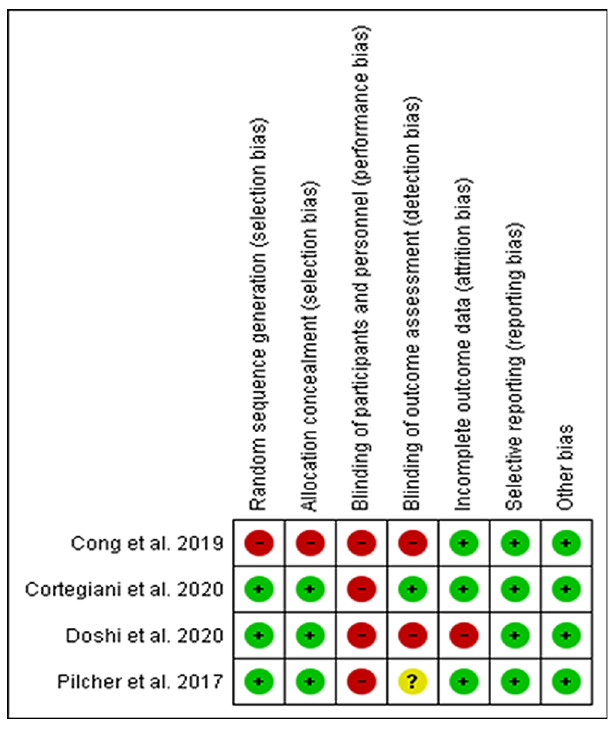
Figure 2. Risk of bias PaCO 2 at various time-points with a similar trend in PaCO 2 (Figure 3). Pilcher et al . 24 compared HFNT with LFO at